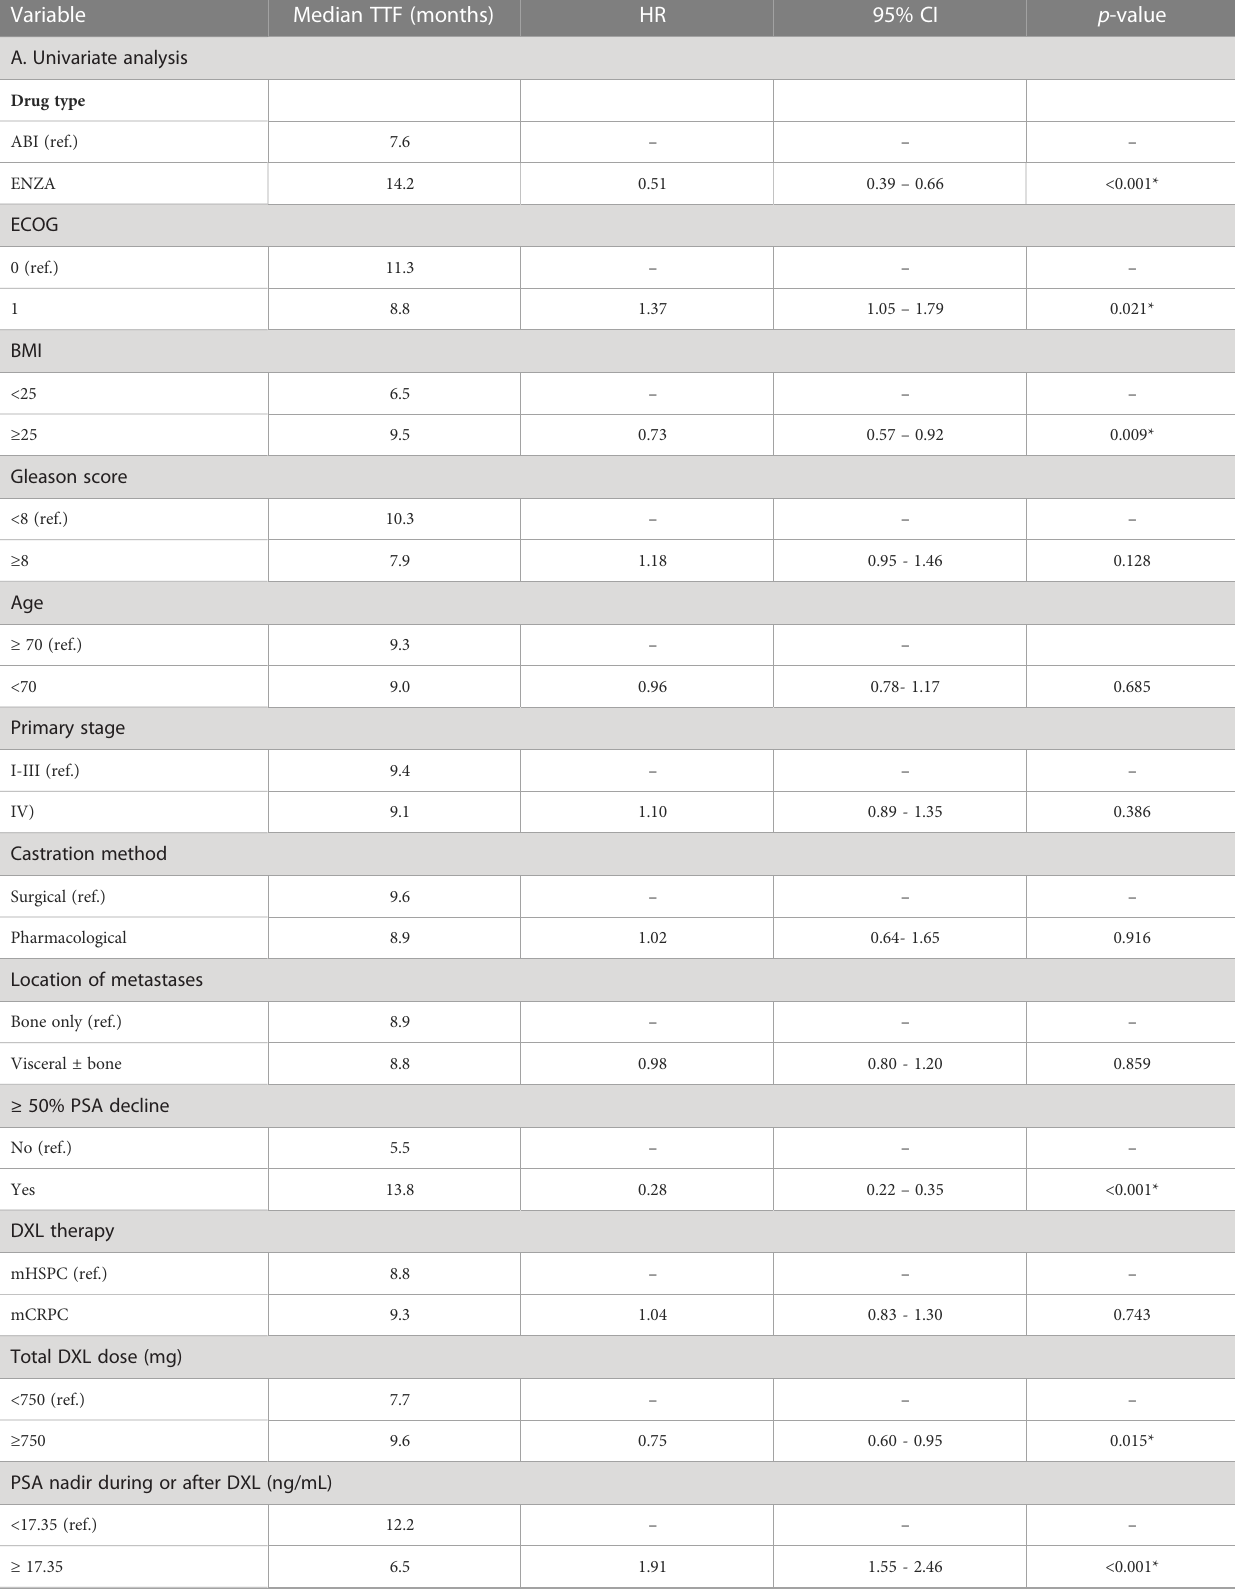
TABLE 2 Predictive factors determining the time to treatment failure (univariate and multivariate